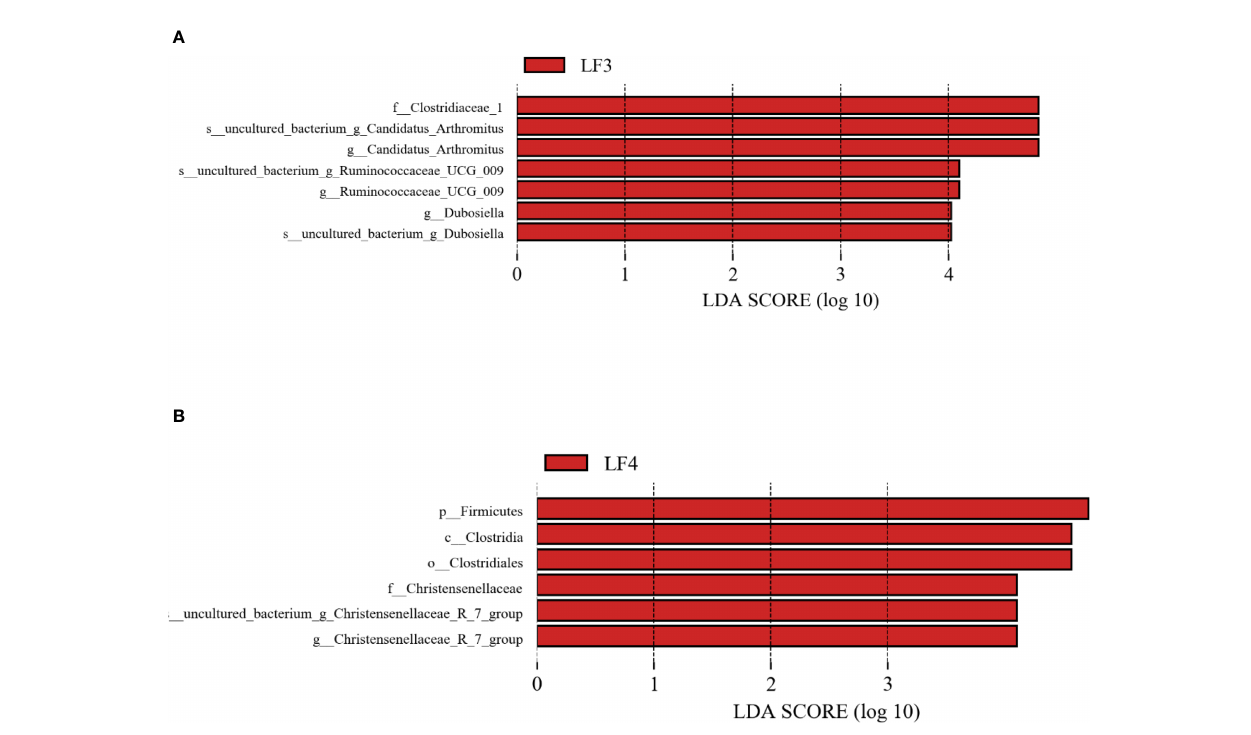
FIGURE 4 | Lineages with linear discriminant analysis (LDA) score of the abundance of taxa. Only the taxa that LDA value above 4.0 are shown. (A) group C vs group LF3; (B) group C vs group